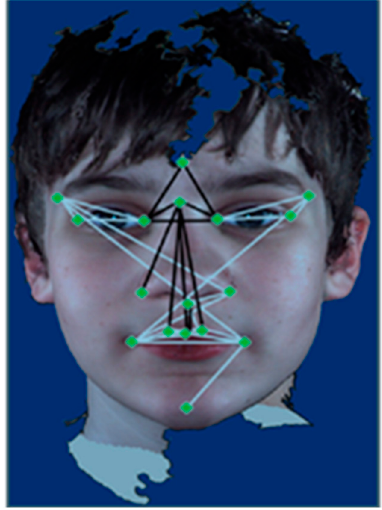
Figure 1. For boys with ASD compared with TD boys: the white lines are statistically significantly increased in length; the black lines are statistically reduced in length [7].